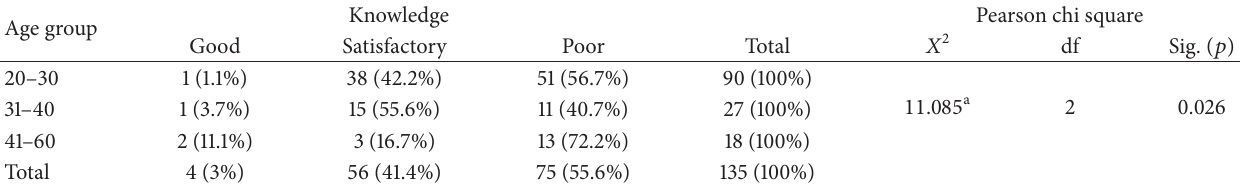
Table 2: Pearson’s chi square association between knowledge and age group (𝑛 = 135)